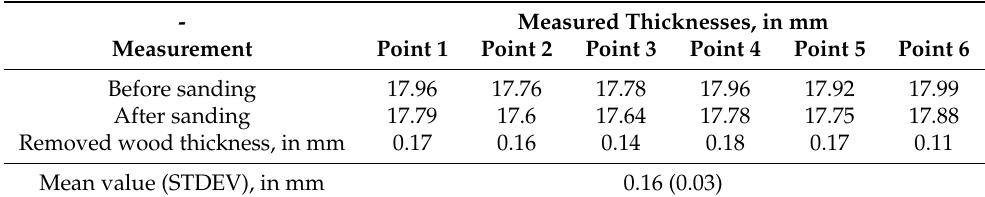
Table 3. Measured thicknesses of the maple panels in six points*, before and after sanding with grit sizes of 100, 120 mm. - Measured Thicknesses, in mm Measurement Point 1 Point 2 Point 3 After sanding Removed wood thickness, in mm Mean value (STDEV), in mm 0.16 (0.03) * All six points are situated 10 mm offset to the length (2 points situated at 1/3 distance to the edge for each length) and to the width (1 point situated at the middle point of the distance).